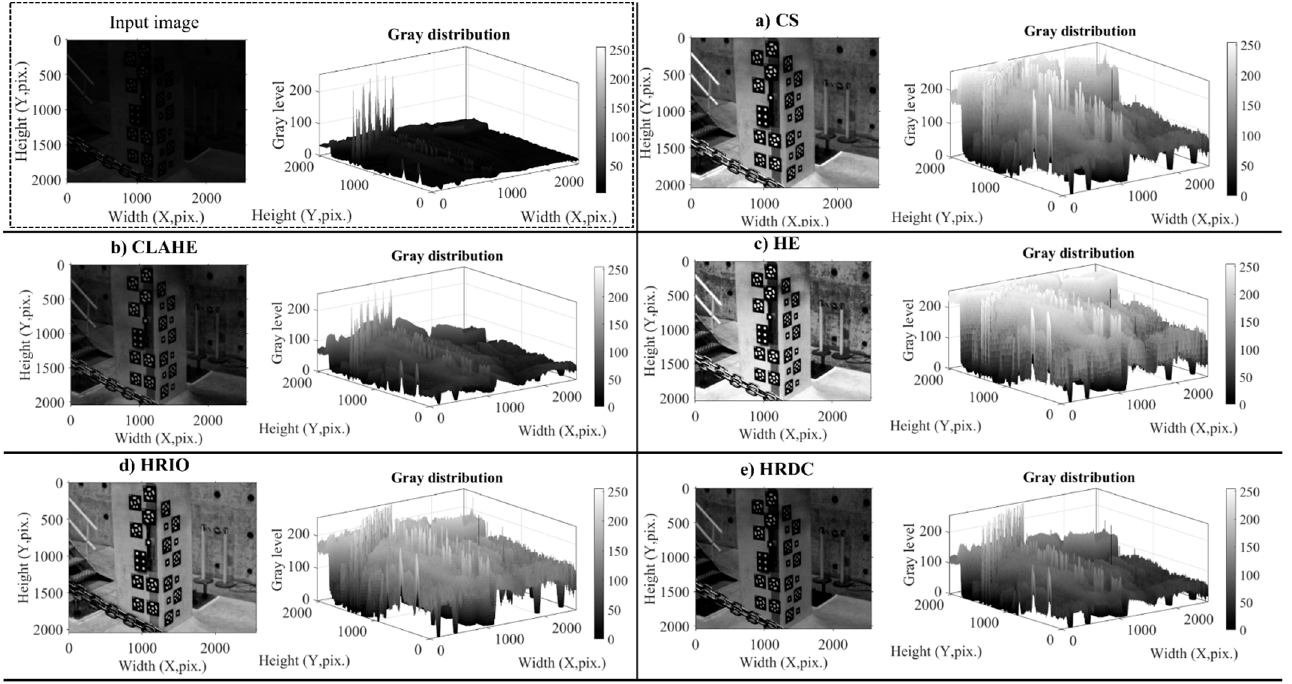
Figure 3. Underexposed input ( top ‐ left ) and enhanced output images with their associated gray level histogram ( a – e